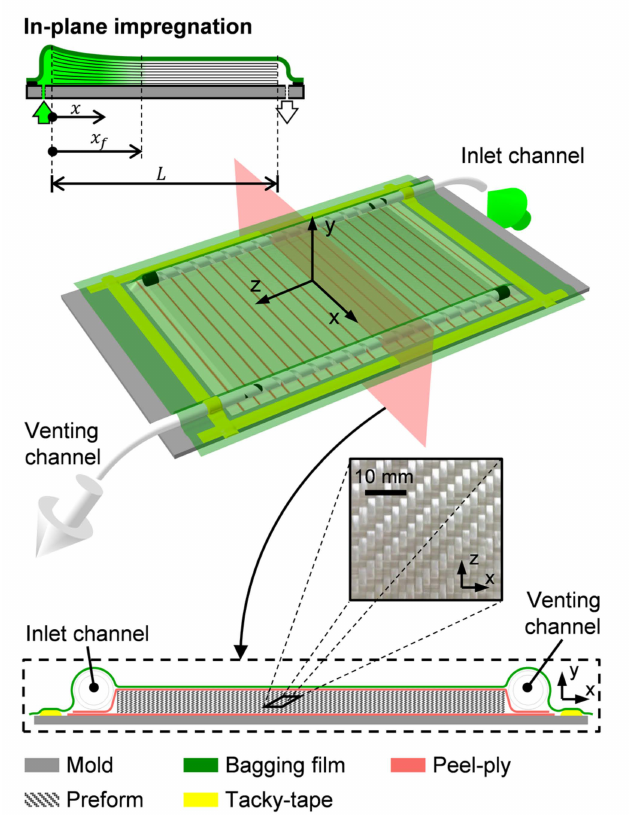
Figure 3. VI preform assembly (schematic dimensions are